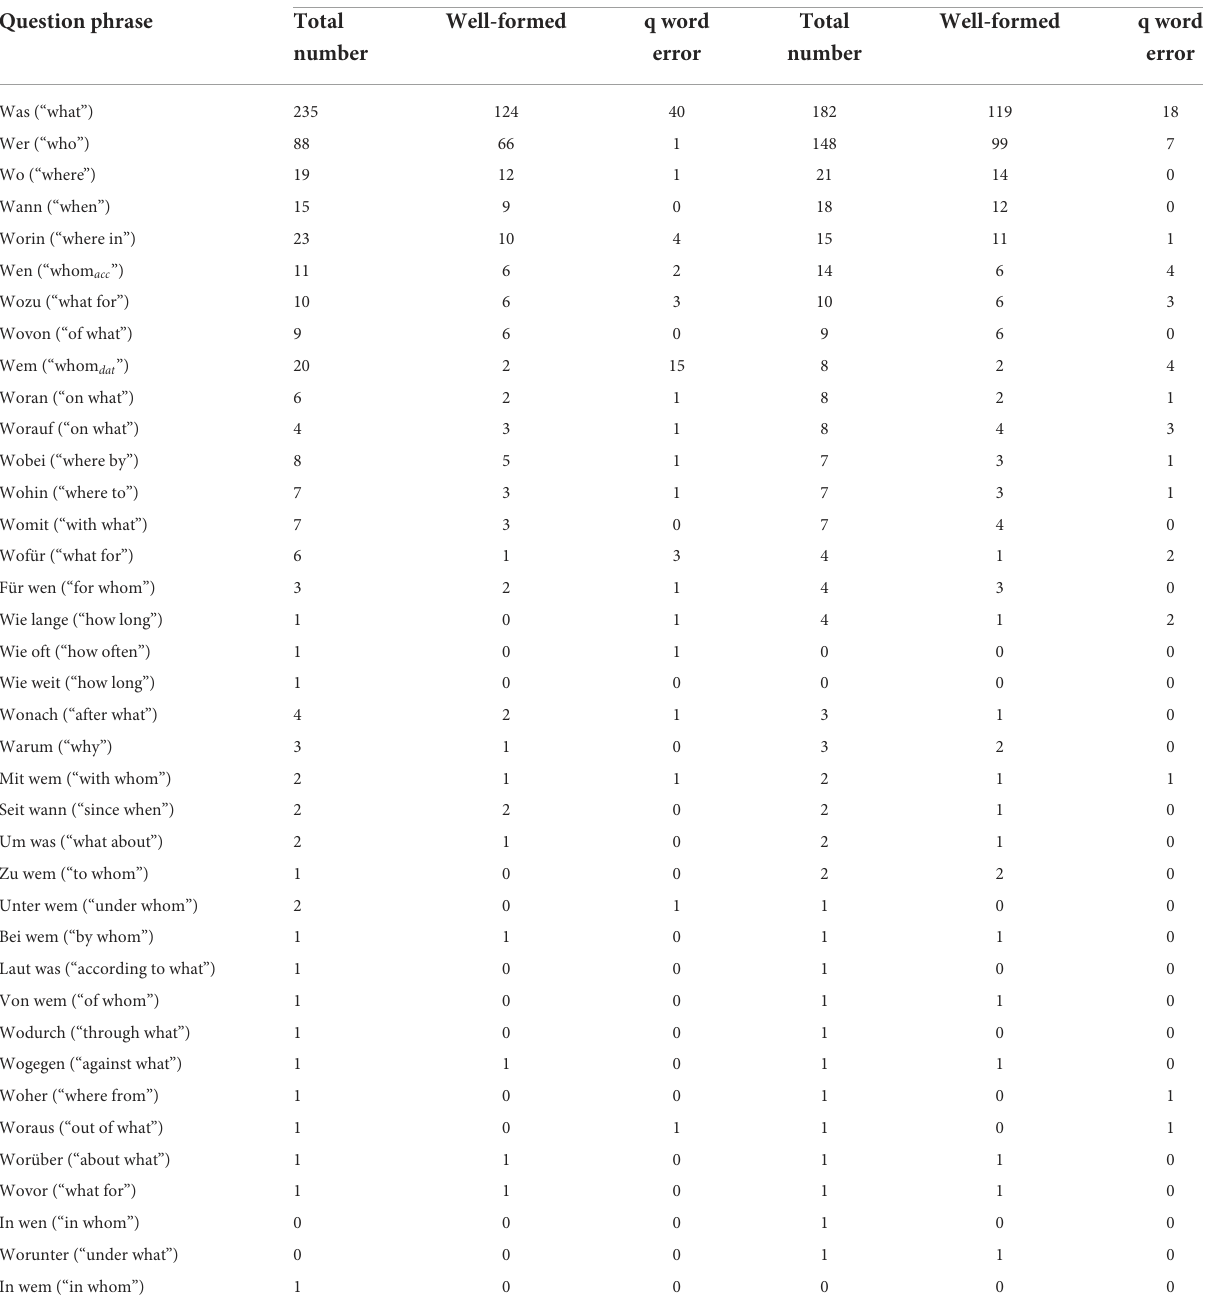
TABLE 6 Types and frequency of question phrases in well-formed questions of the 500